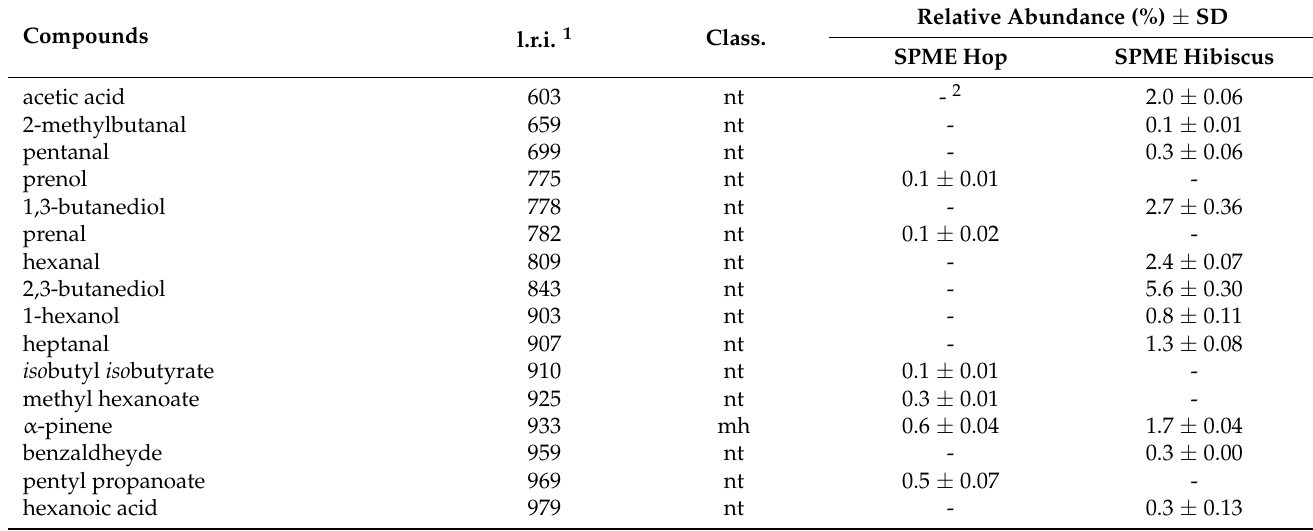
Relative Abundance (%) ± SD SPME